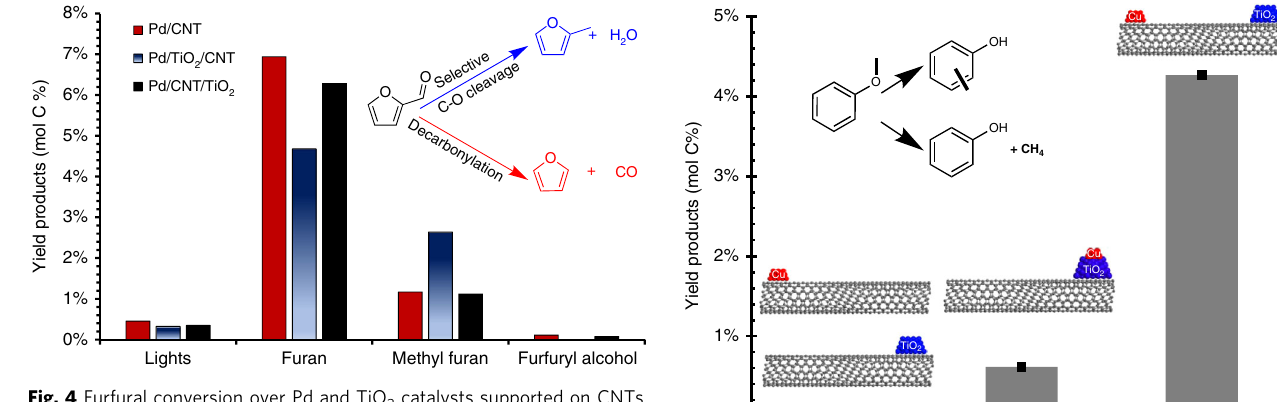
Fig. 4 Furfural conversion over Pd and TiO 2 catalysts supported on CNTs. T = 400 o C, P = 1 atm, under fl owing H 2 , 30 min time on stream (TOS). The “ lights ” represent the sum of ring opening products and products resulting from the hydrogenation of CO found in low abundance. The inset Fig. 5 Anisole conversion over catalysts containing Cu and TiO 2 . Sum of to the upper right indicates the two primary competing reaction pathways quanti fi able products (cresol + phenol) resulting from anisole conversion to form furan or methylfuran over Cu and TiO 2 catalysts supported on CNTs. T = 400 °C, P = 1 atm, under a H 2 fl ow, 100 min TOS. The inset in the upper left indicates the main conversion products resulting from anisole under these conditions to generate cresol or